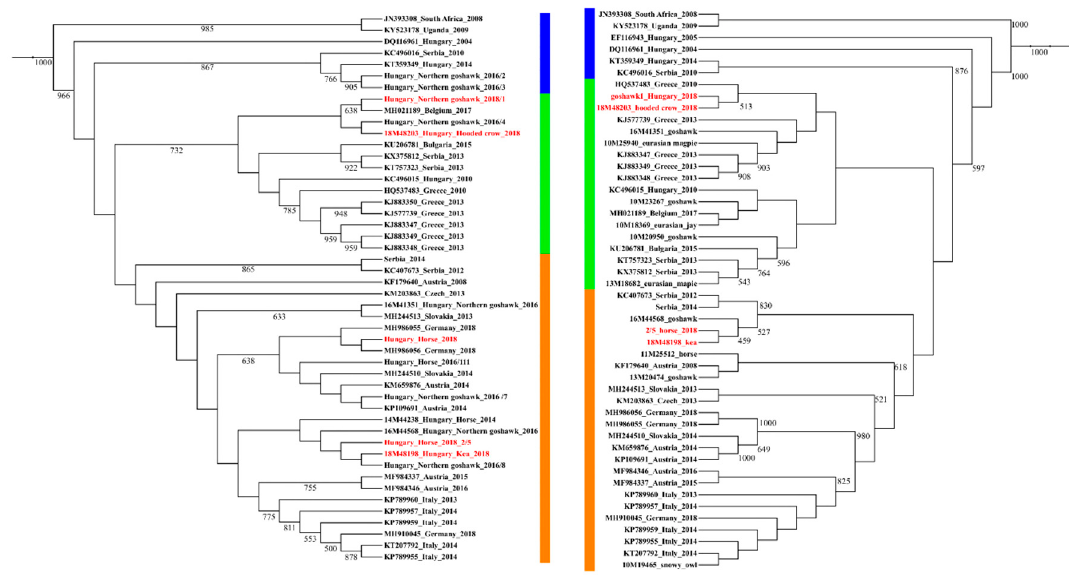
Figure 4. Phylogenetic representation of partial NS3 (left side) and NS5 (right side) gene sequences of Hungarian horse and wild bird samples compared to cognate sequences from the region, collected between 2010 and 2018. Progenitor African, Hungarian, and a Serbian WNV lineage 2 strains are highlighted with blue outline, while the two major subclades are indicated with green (Balkanian subclade) and orange (Central/South-West European subgroup) outline. Samples from 2018, Hungary, are highlighted with red color. Note MH021189 as an imported case from Hungary to Belgium [36].